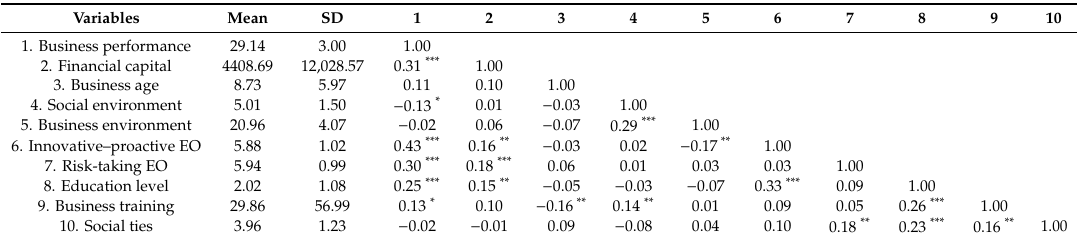
Table 3. Descriptive statistics and Correlations (N =